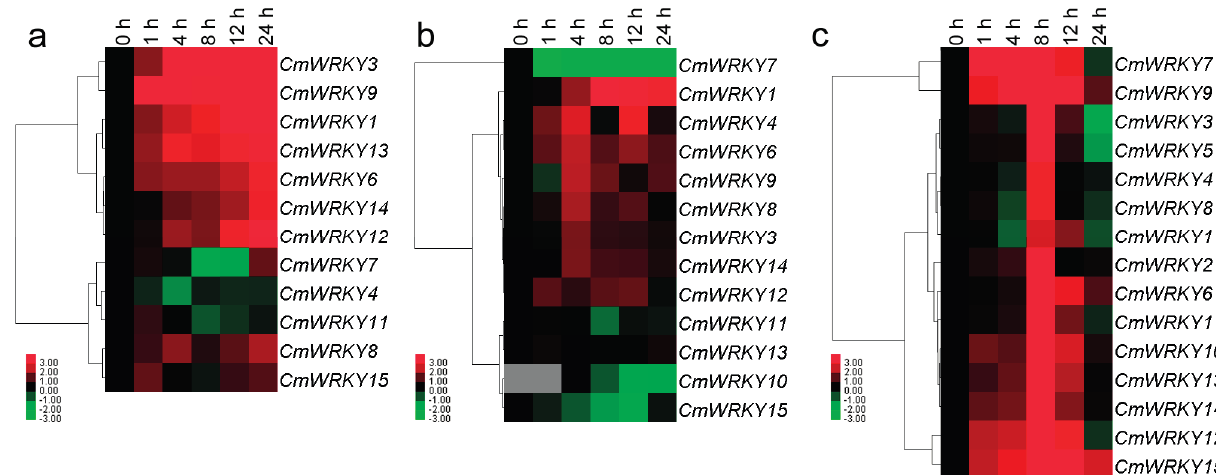
Figure 5. Differential transcription of CmWRKY genes as induced by abiotic treatments at the seedling stage. ( a ) roots in salinity; ( b ) roots in moisture stress; ( c ) leaves in low temperature; ( d ) leaves in high temperature and ( e ) leaves undergo wounding. Green indicates lower and red higher transcript abundance compared to the relevant control. Grey blocks indicate that transcription was not